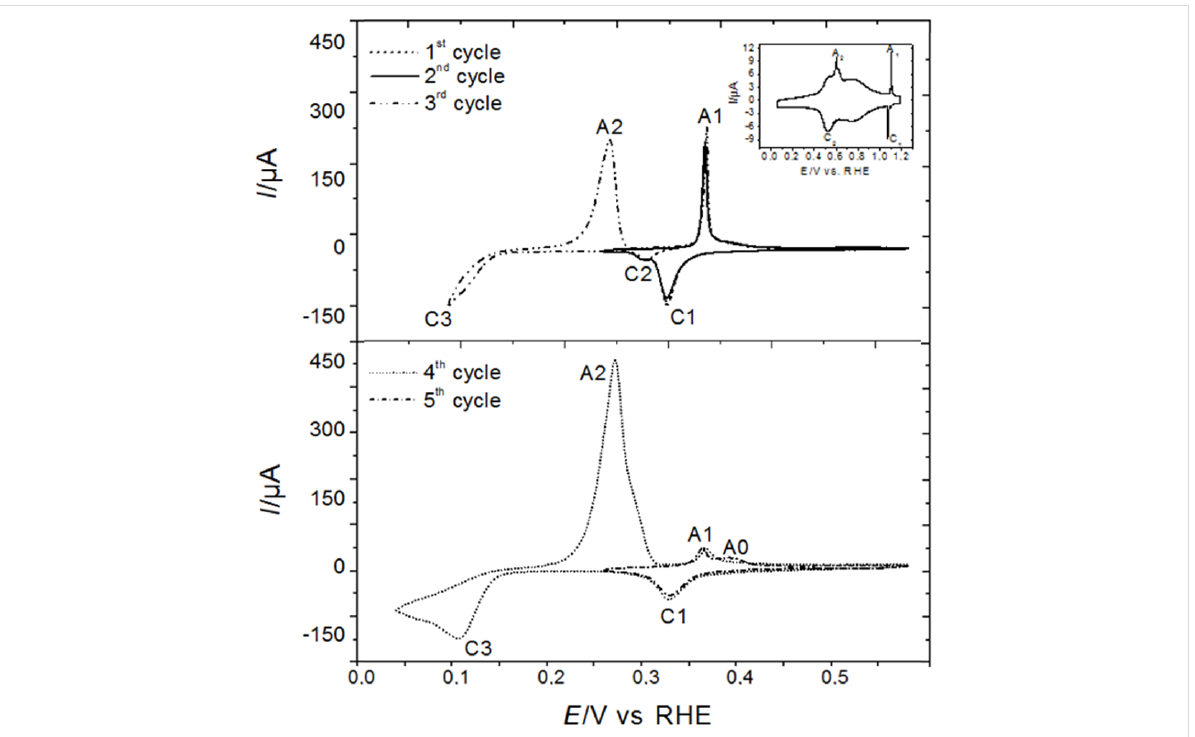
Figure 1: Cyclic voltammograms of Sb deposition on Au(111) in 0.25 mM Sb 2 O 3 /0.5 M H 2 SO 4 electrolyte saturated with Ar in an H-cell at 10 mV s − 1 . Inset: Cyclic voltammogram of Au(111) in 0.1 M H 2 SO 4 solution saturated with Ar in an H-cell at 50 mV s − 1 to demonstrate the Au(111) surface.